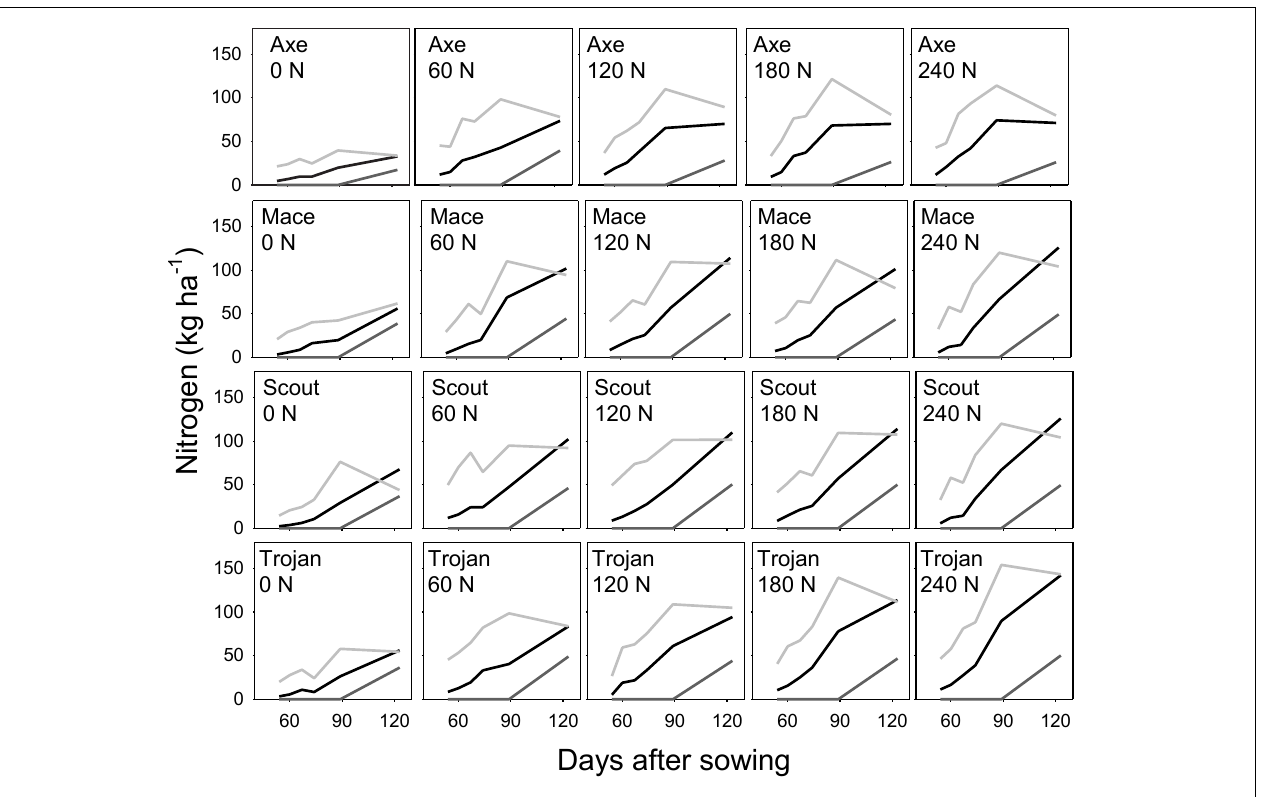
FIGURE 3 | Dynamics of nitrogen uptake in leaf (light gray), stem (black), and ear (dark gray) for wheat crops in a factorial experiment combining four varieties and five rates of nitrogen fertilizer. Data from irrigated crops at Roseworthy, 2016.